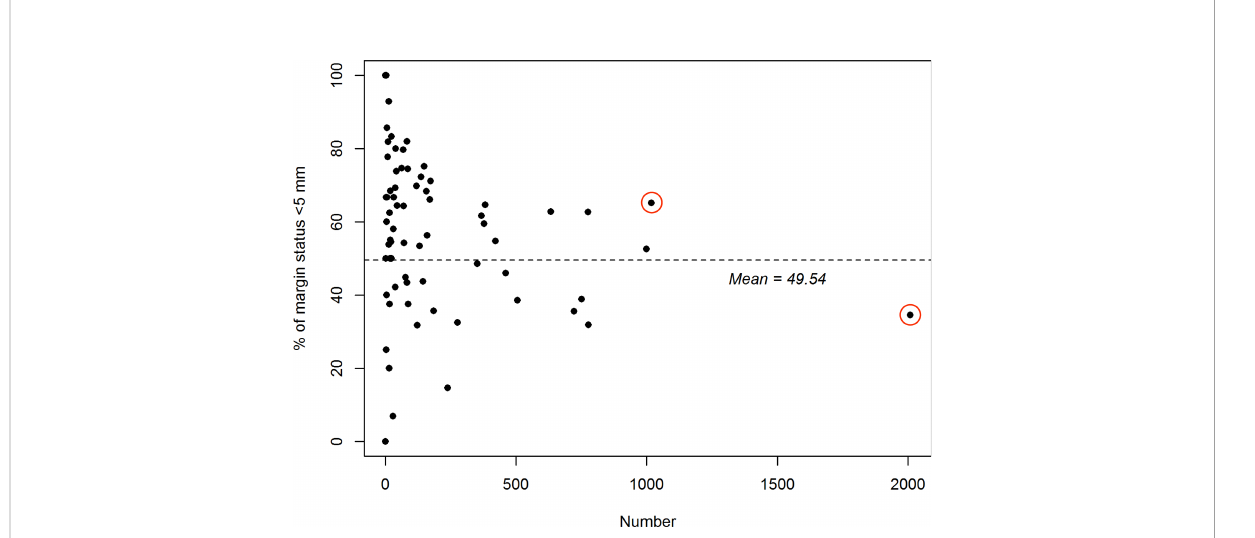
FIGURE 2 Relationship between hospital volume (plotted on the x-axis; scale: number of treated patients) and the proportion of patients with margins <5 mm (plotted on the y-axis) in 75 Taiwanese hospitals specializing in the treatment of oral cavity squamous cell carcinoma. The red circles denote the two hospitals included in the study.